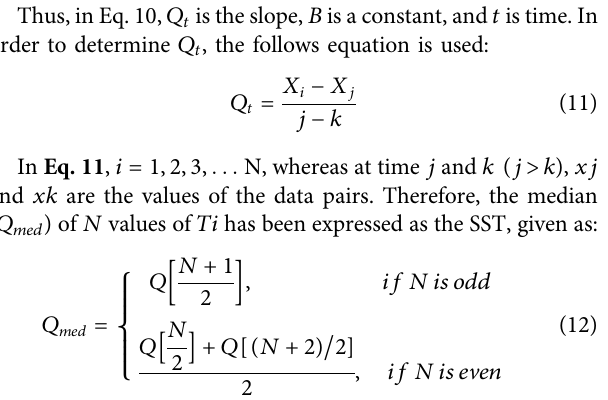
Frontiers in Earth Science |